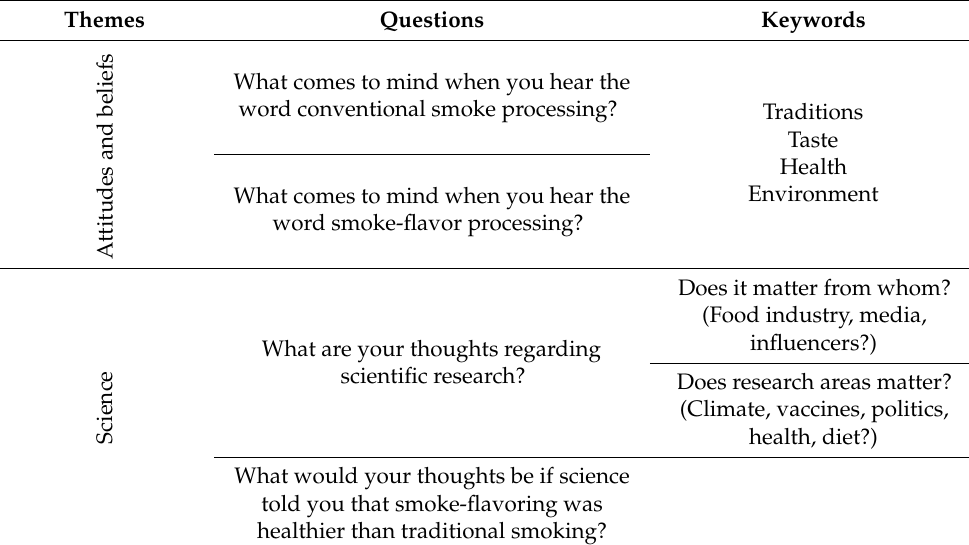
Table A2. Predefined themes, questions, and keywords